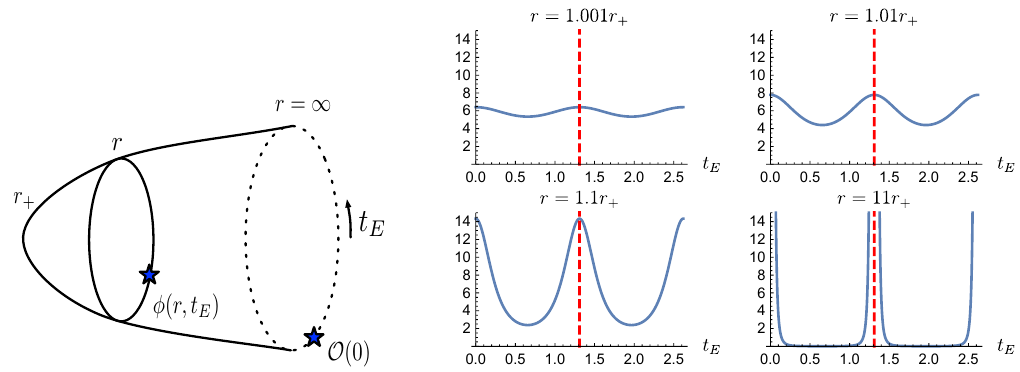
semi on the BTZ 0 j jV semi on constant- r slices. The 0 V